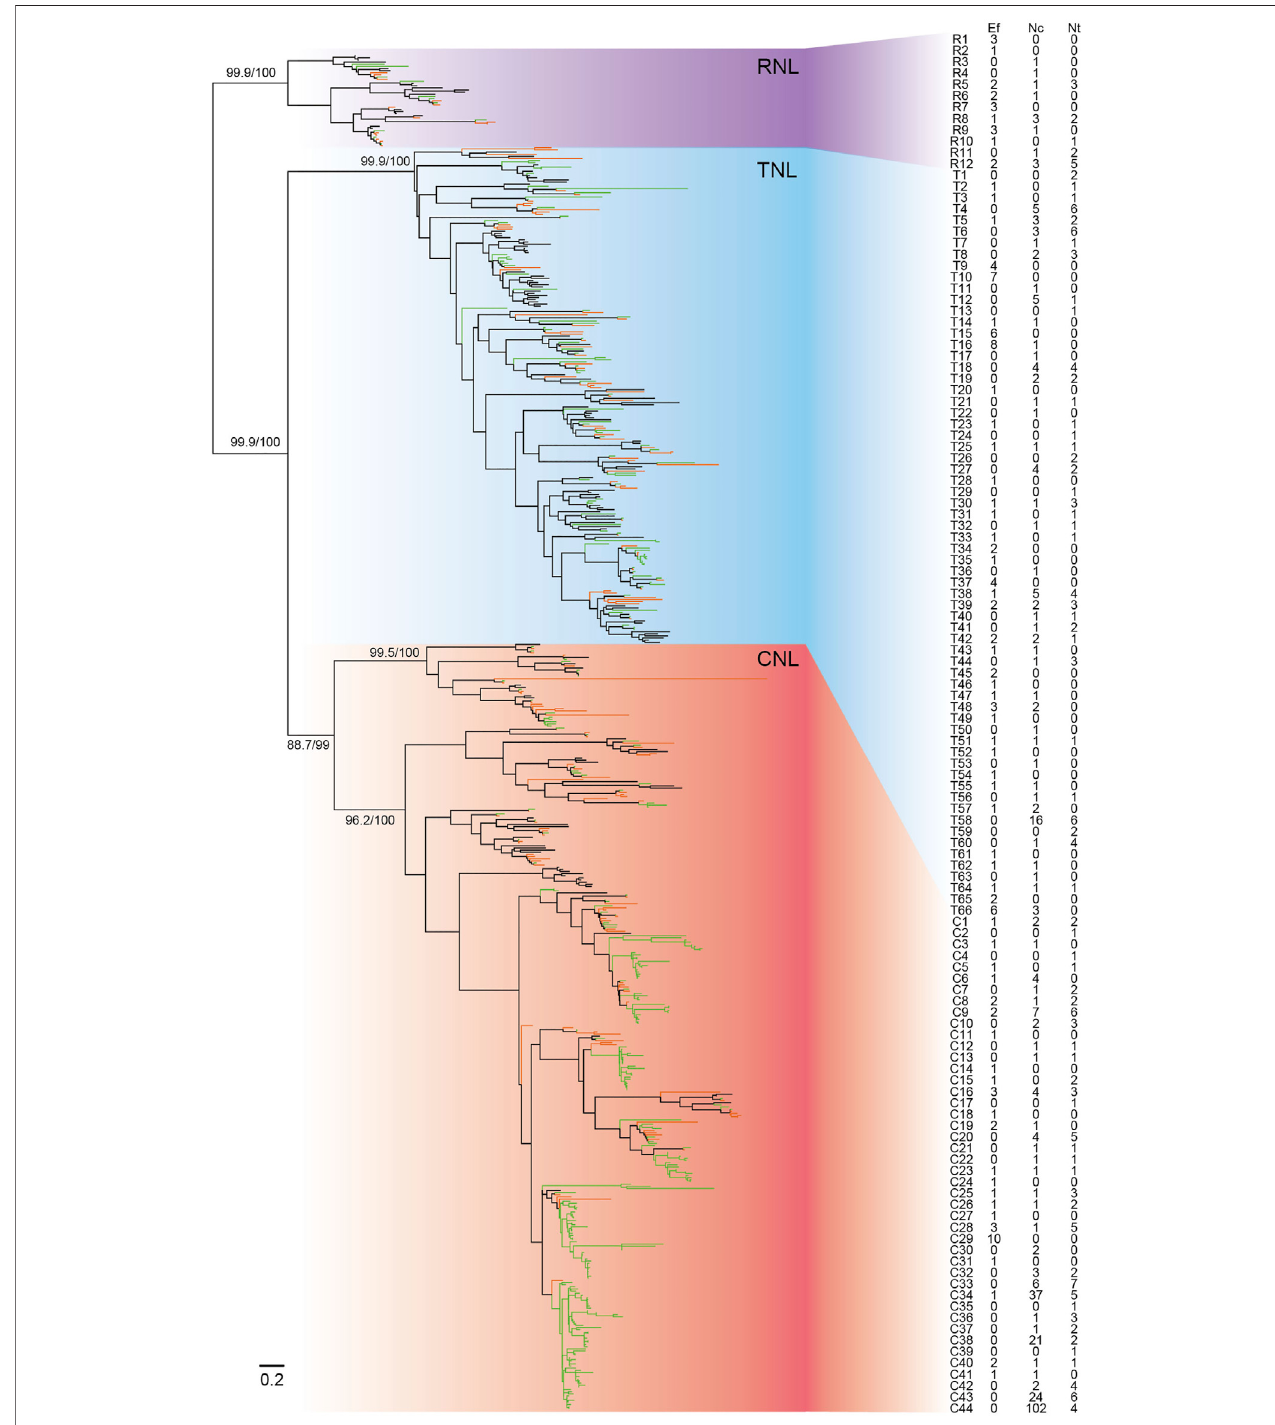
FIGURE 4 | Phylogeny of NBS-LRR genes of E. ferox, N. colorata , and N. thermarum . The phylogeny was constructed based on the conserved NBS domain of NBS-LRR genes from E. ferox (Ef, green branches), N. colorata (Nc, orange branches), and N. thermarum (Nt, black branches). Branch support values obtained from a UFBoot2testarelabeledonbasalnodes.Predictedancestrallineagesarelabeledwithnumbers.Thedetailedphylogenetictreeisshownin SupplementaryFigureS1 .